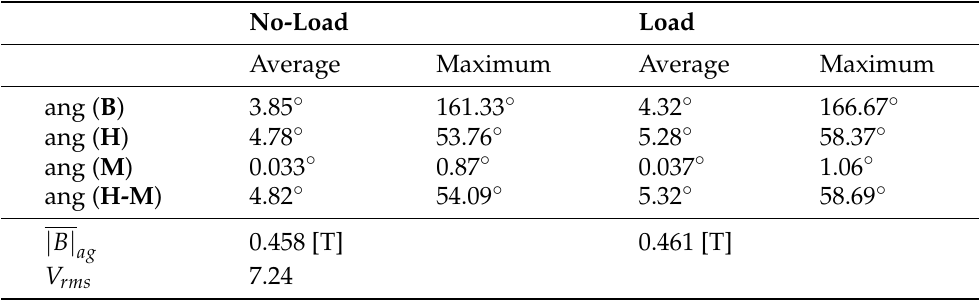
Table 2. The averaged and maximum angular dependency of magnetic flux density, B , magnetic field strength, H , and magnetization, M , for the default case of the linear machine, denoted ang(). The averaged magnitude of the air gap flux density for no-load and load, and the no load RMS voltage are also tabulated.